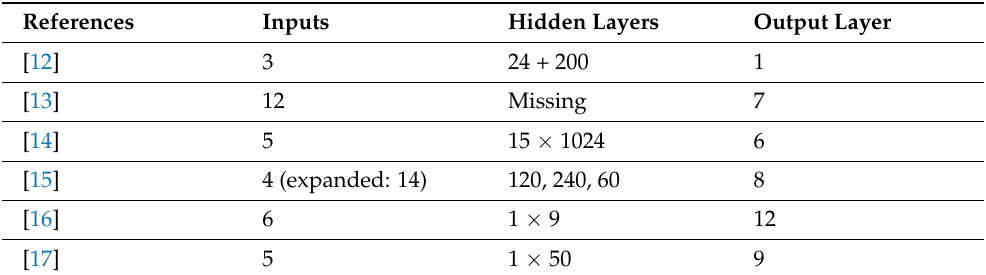
Table 3. Complexities in terms of number of neurons for the different NN structures used in prior